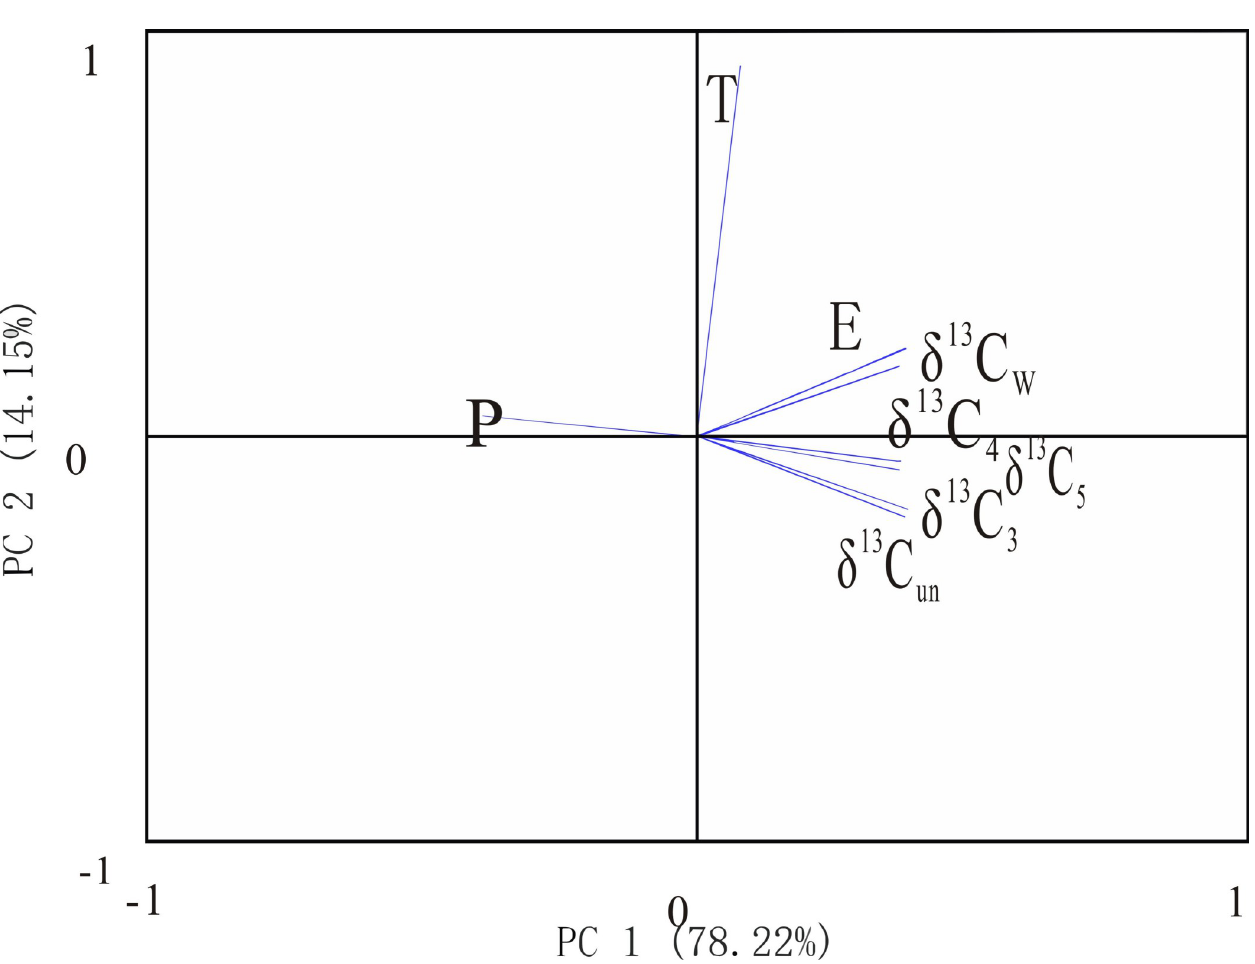
Fig 5. Component weights plot of the principal components analysis ( Quercus ). (P is precipitation; T is temperature; E is evaporation; δ 13 C un (without carbonization); δ 13 C 3 (300˚C carbonization condition), δ 13 C 4 (400˚C carbonization condition), δ 13 C 5 (500˚C carbonization condition), and δ 13 C w (wildfire carbonization condition).